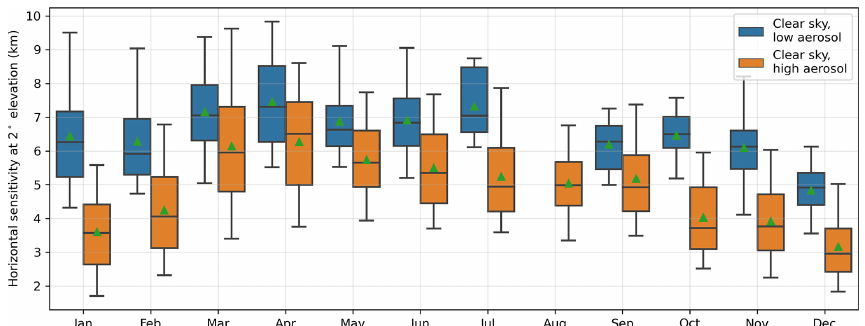
Figure F13. Box-and-whiskers plot showing the horizontal sensitivity distance of MAX-DOAS measurements during afternoon hours (be- tween 12:00 and 15:00LT) for 2 ◦ elevation angle. The blue boxes represent clear-sky conditions with low aerosol load, and the orange boxes indicate clear-sky conditions with high aerosol